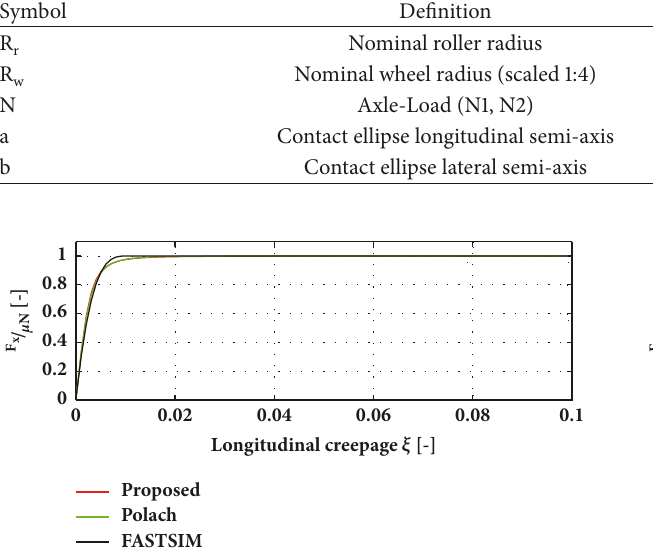
Figure 3: Longitudinal force versus pure longitudinal creepage.